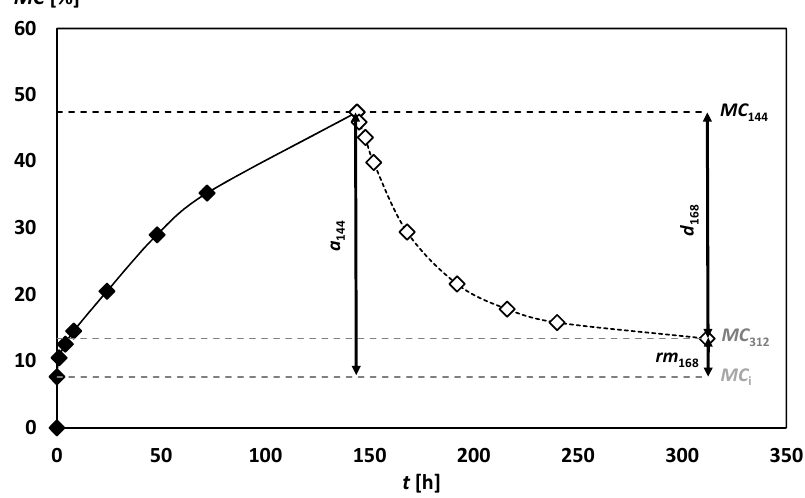
Figure 2. Moisture content ( MC ) development over 144 h water uptake and 168 h desorption cycle determined in a submersion test, the initial MC ( MC i ), the MC after 144 h of water uptake ( MC 144 ) and the MC after 168 h of desorption ( MC 312 ) of Norway spruce (150 (ax.) × 50 × 25 mm 3 ). Indicators and Calculations from Floating and Submersion Tests